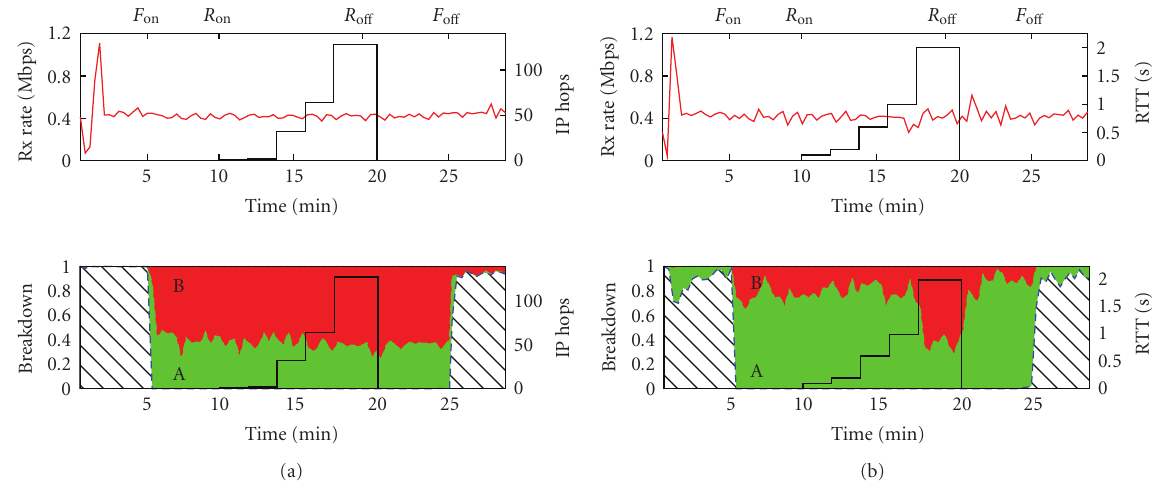
Figure 3: Pathwise metrics: PPLive aggregated received rate at P (top) and its breakdown between A, B and Internet hosts (bottom) for varying IP hop distance (a) and RTT delay (b). Profiles of the IP hop distance and RTT delay impairments are reported as solid black lines directly in the plot and refer to the right y -axis. Here, PPLive shows no awareness of IP distance and a mild sensitiveness towards Round Trip